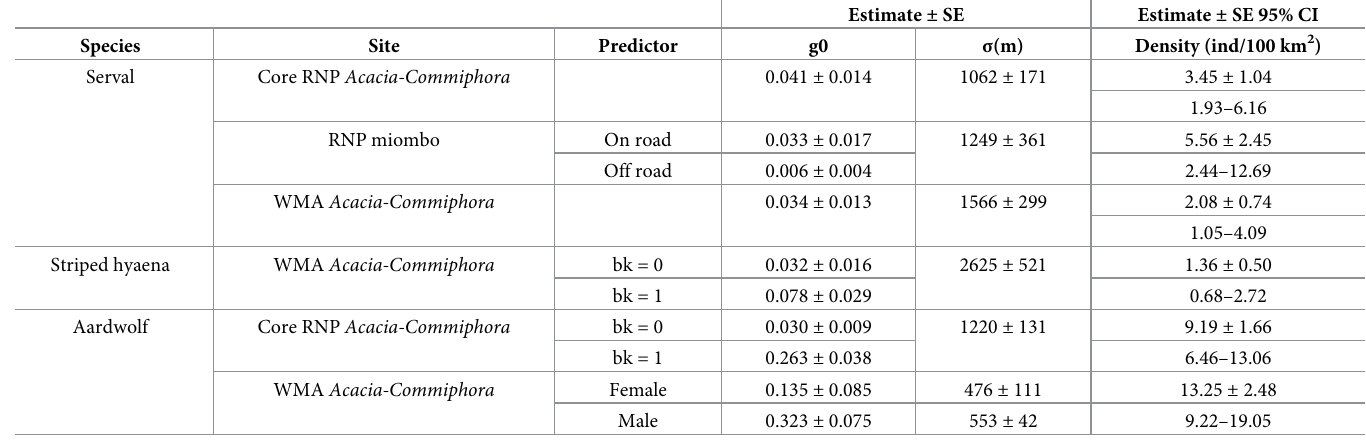
Table 1. Population density and parameter estimates, with standard errors/95% confidence intervals for the target species at the three survey